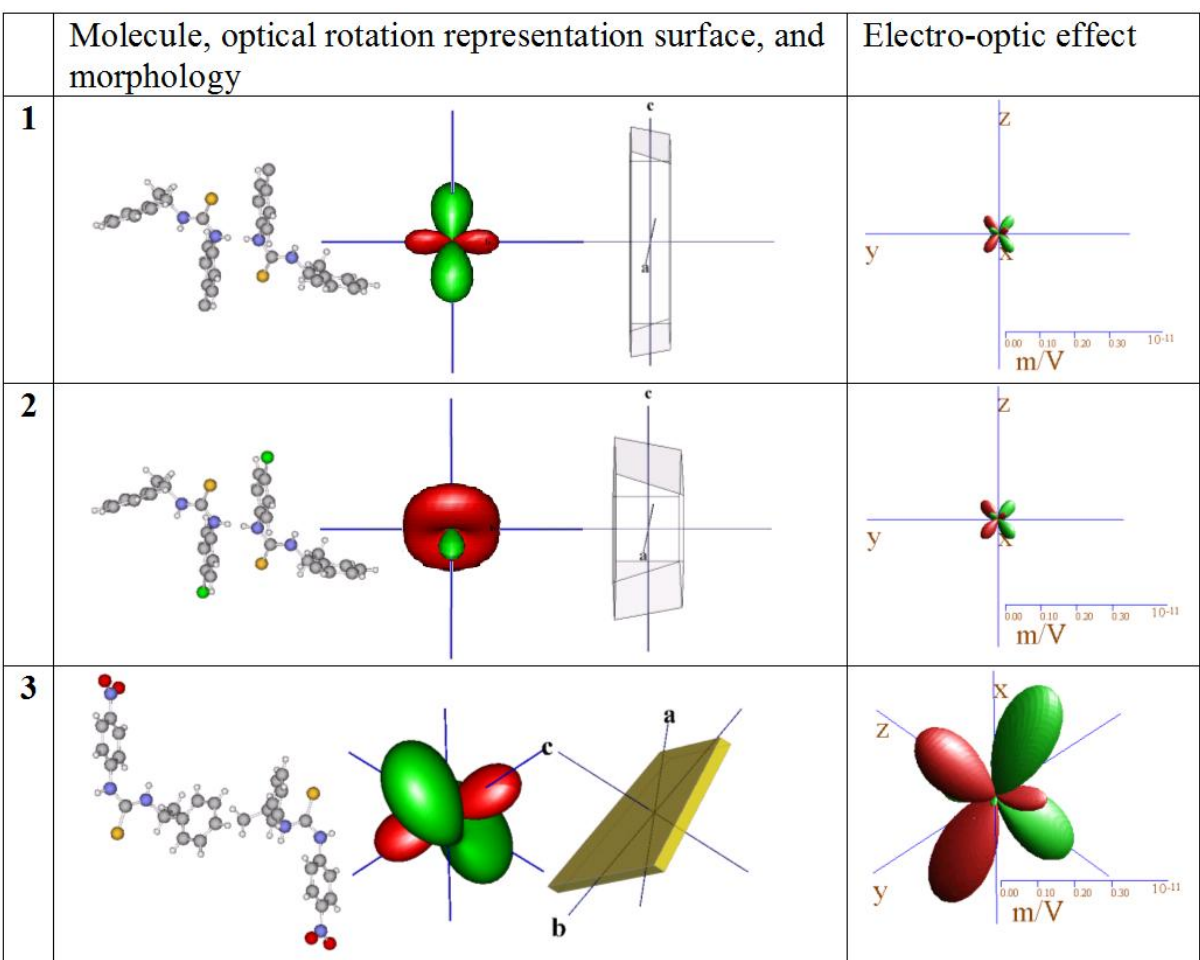
Figure 5. Molecules in similar orientation, representation surface for optical rotation, morphology of typical specimen, and the electro-optic effect, shown to scale to enhance comparison between